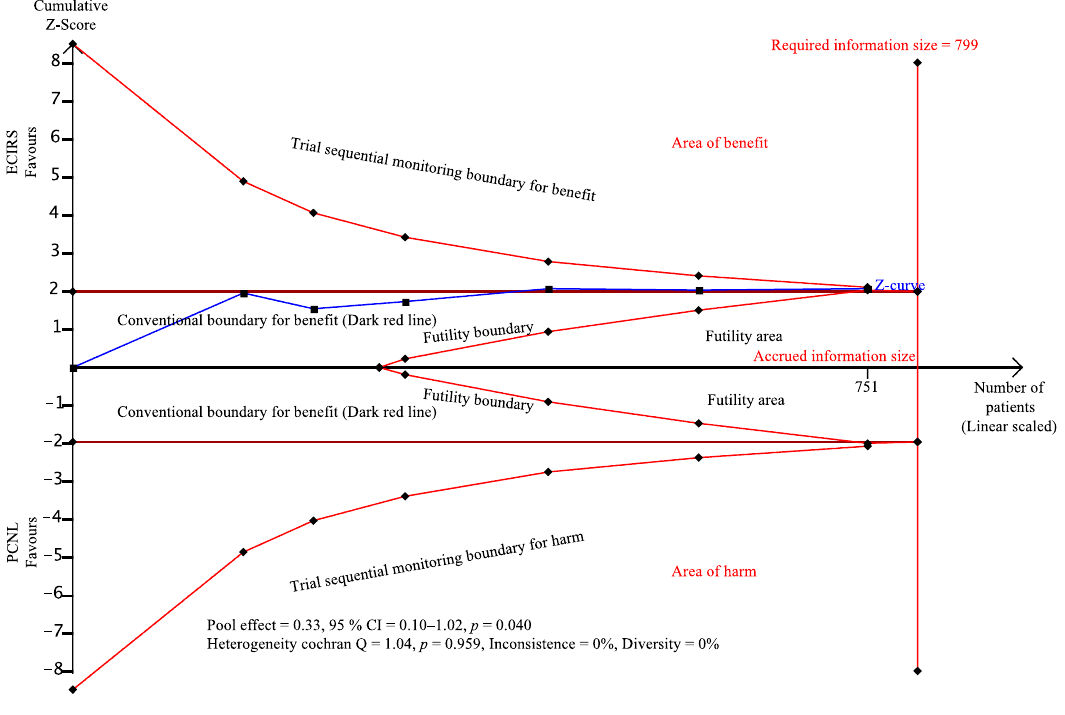
Figure A52. Trial sequential analysis of outcome regarding required blood transfusion.